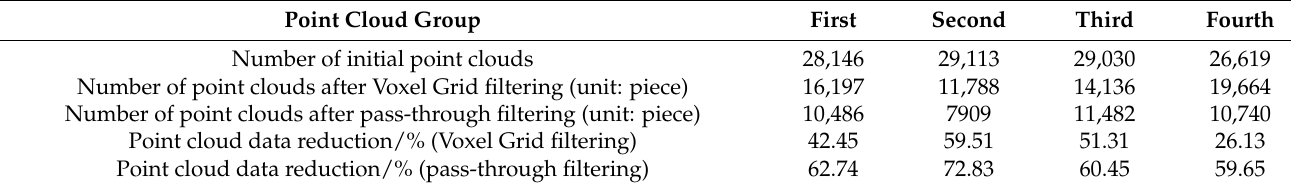
Figure 8. Point cloud data pretreatment. Table 1. Experimental data of laser point cloud pretreatment.